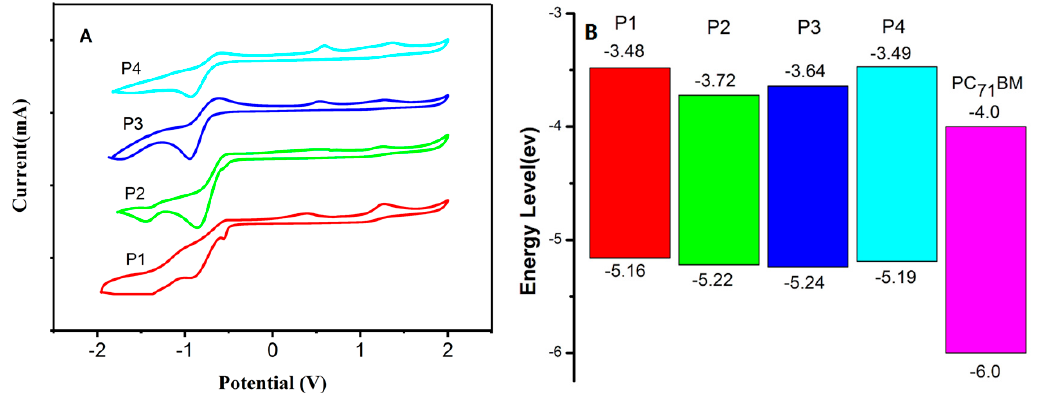
Figure 3. Cyclic voltammetric curves ( A ) and energy levels ( B ) of the polymers (estimated by the empirical relationship proposed by de Leeuw et al. [33]).